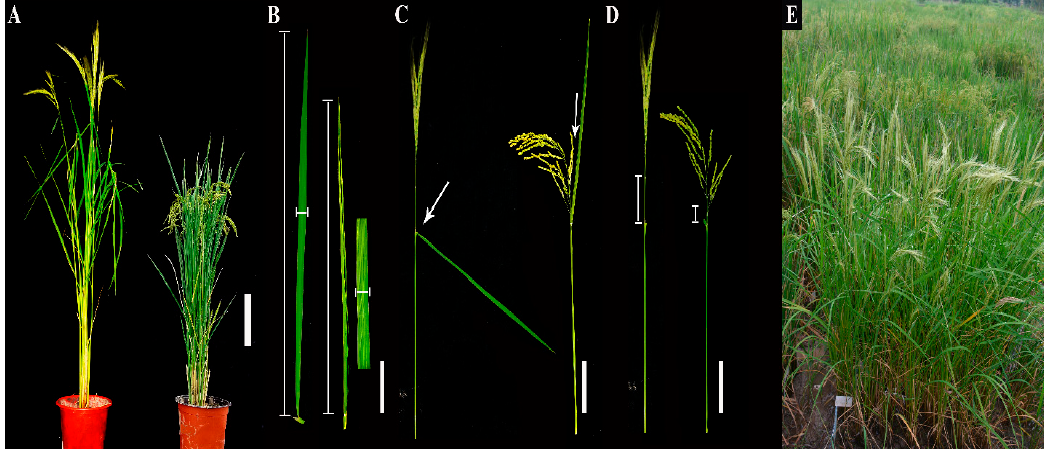
Figure 1. The plants, flag leaf blades, and panicles of parents, and partial lines in the population of chromosome segment substitution line with C bao as a receptor parent and Ludao as a donor parent (CL ‐ CSSL) growing in the paddy rice field. ( A ) Plants of Ludao (left) and C ‐ bao (right); ( B ) Flag leaf blade length and width; ( C ) Flag leaf angle; ( D ) Panicle neck length; ( E ) Partial lines of the CL ‐ CSSL population, showing a difference between two parents and variation among lines in the CL ‐ CSSL population.